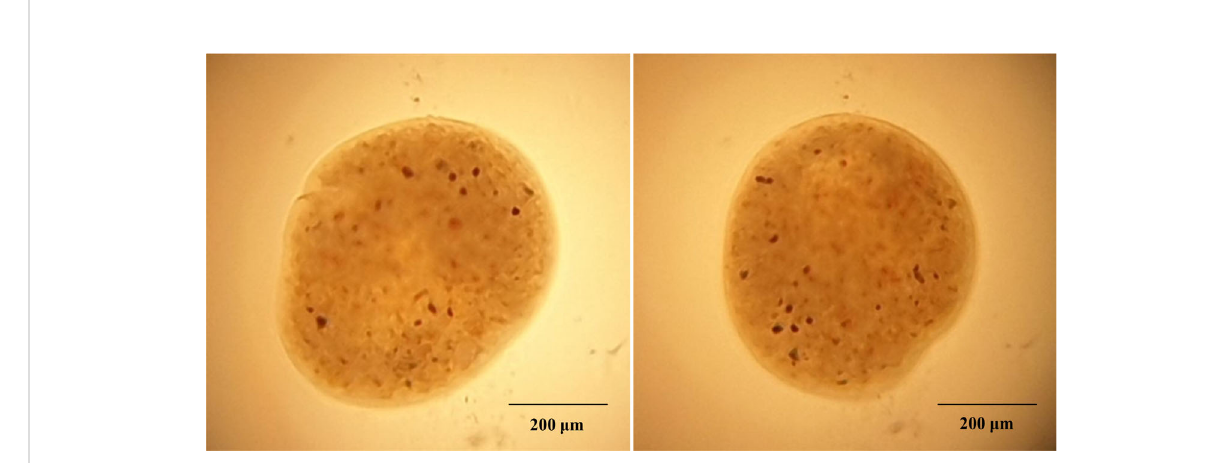
FIGURE 2 Observation of wet mounts prepared from infected P. hypophthalmus . The presence of round to oval shape large ciliated parasite (trophont) indicates the presence of I. multi fi liis .